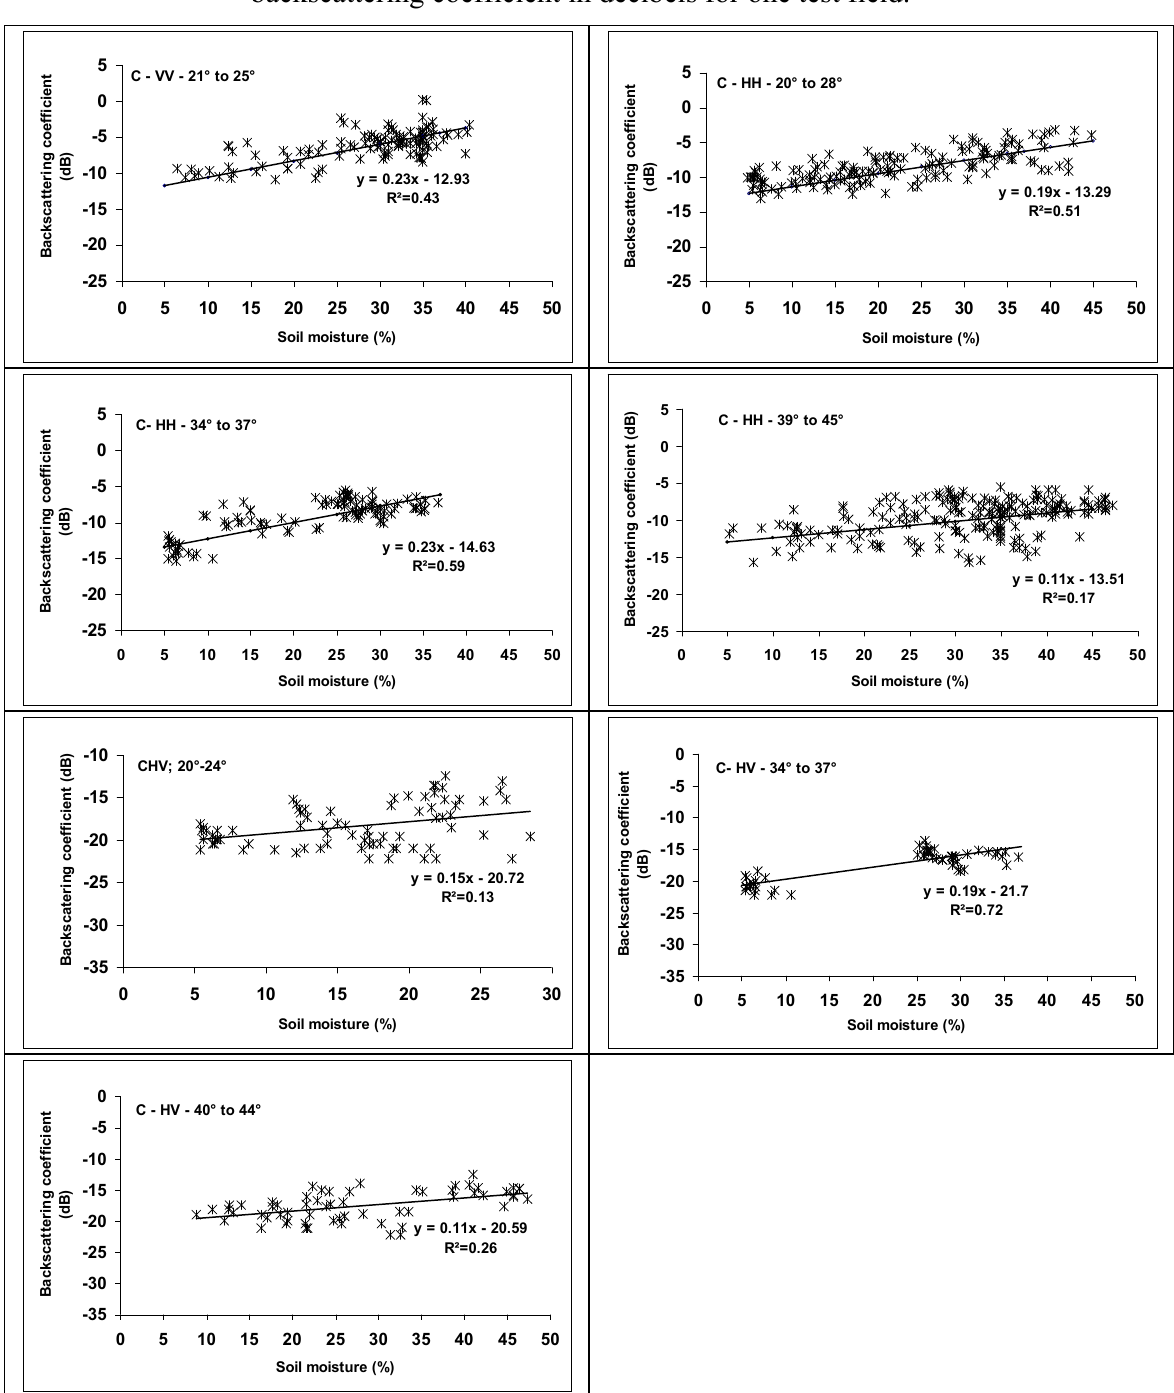
Figure 3. Sensitivity of radar signal in C-band ( ∼ 5.6 GHz) to surface soil moisture as a function of incidence angle and polarization. Results were obtained from ERS, RADARSAT-1 and ASAR data for clay loam sites (silt: 42 to 78%, clay: 13 to 40%, sand: 5 to 24%). Each point corresponds to the average backscattering coefficient in decibels for one test